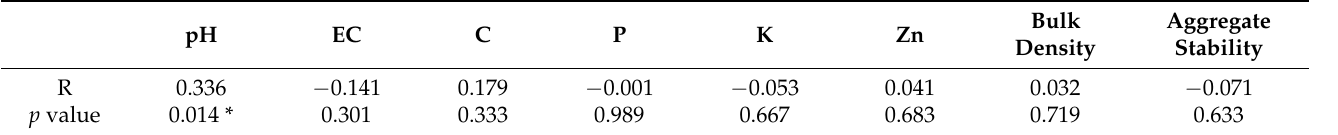
Table 4. Correlation analysis between soil characteristics and fungal communities using the Mantel test.